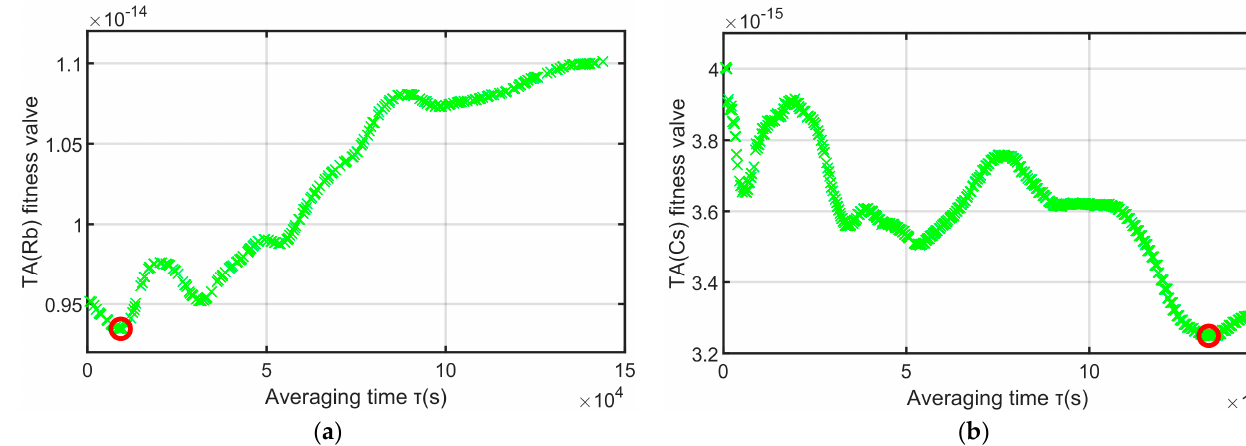
Figure 7. Genetic algorithm fitness.